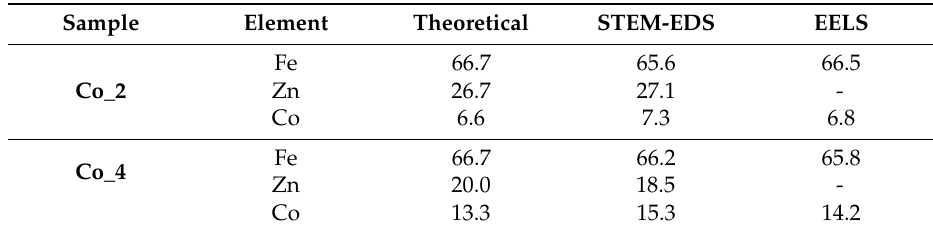
Table 2. Quantitative analysis results in atomic % obtained from EDS and EELS measurements for Co_2 and Co_4 samples.